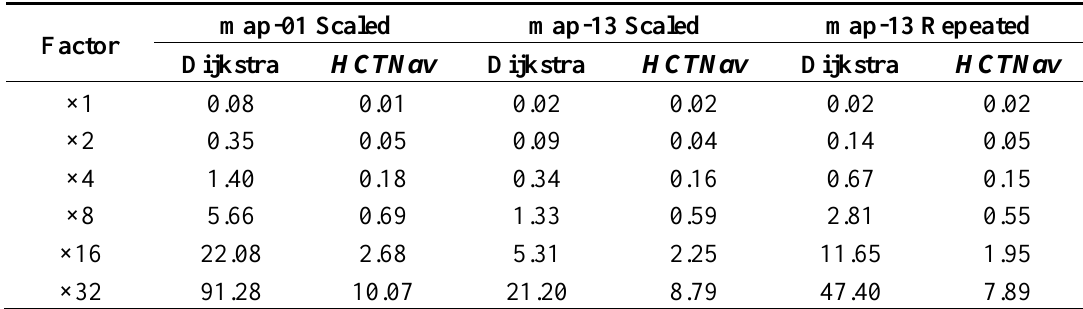
Table 1. Simulation results for the scalability analysis. The dynamic memory peaks are expressed in MB.